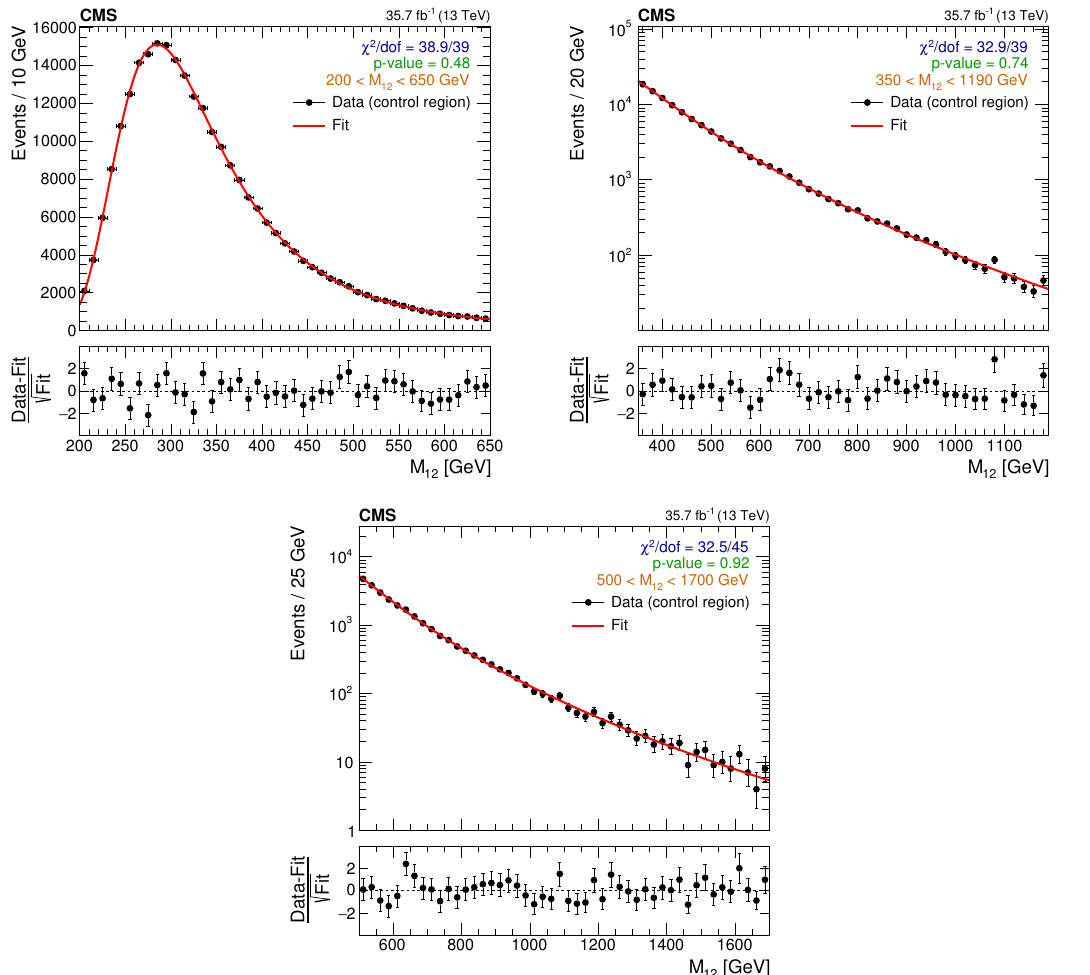
Figure 4 . Distributions of the dijet invariant mass M 12 , obtained from the b tag veto CR as described in the text in the three subranges used for the (cid:12)t: M 12 = [200 ; 650] GeV (upper left) in linear scale, M 12 = [350 ; 1190] GeV (upper right) and M 12 = [500 ; 1700] GeV (lower) in logarithmic scale. The dots represent the data. The full line is the result of the (cid:12)t of the background pa- rameterizations described in the text. In the bottom panel of each plot, the normalized di(cid:11)erence p [(Data-Fit)/ Fit] is